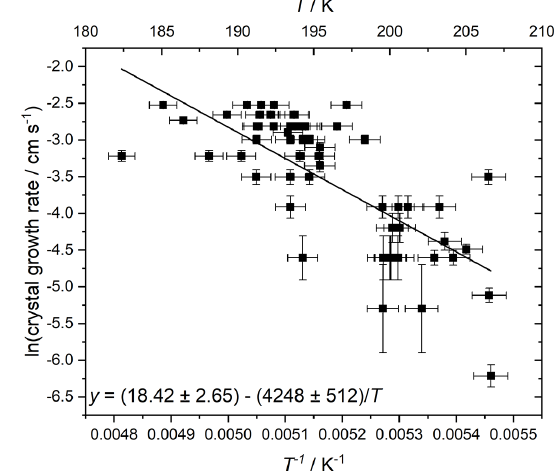
Figure 7. Arrhenius fit to crystal growth rate to determine diffusion barrier from 40% HNO 3 liquid to crystalline NAT. Horizontal error bars are a result of uncertainty in the temperature control and mon- itoring, vertical error bars were propagated from uncertainty in the measurement of crystal front position and the variability between video